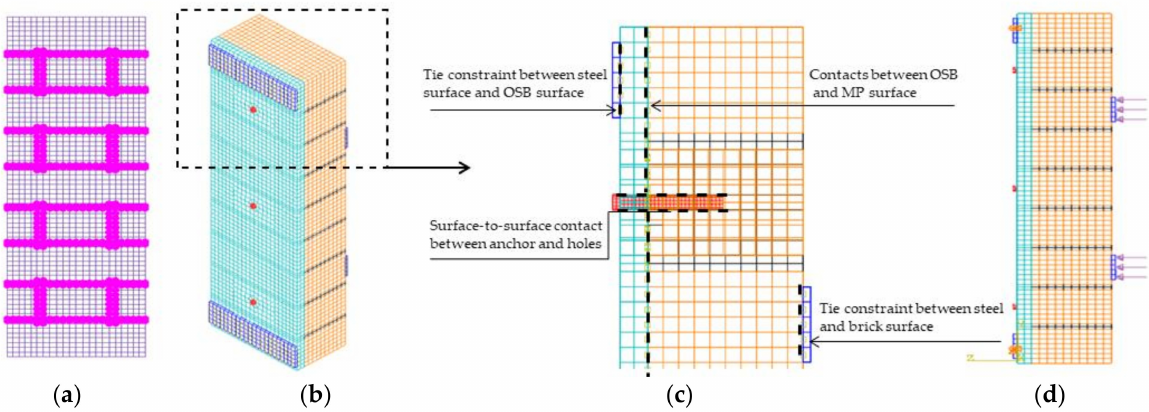
Figure 14. FE model: ( a ) part merging, ( b ) model assembly, ( c ) details of contact interaction between parts, ( d ) loading and